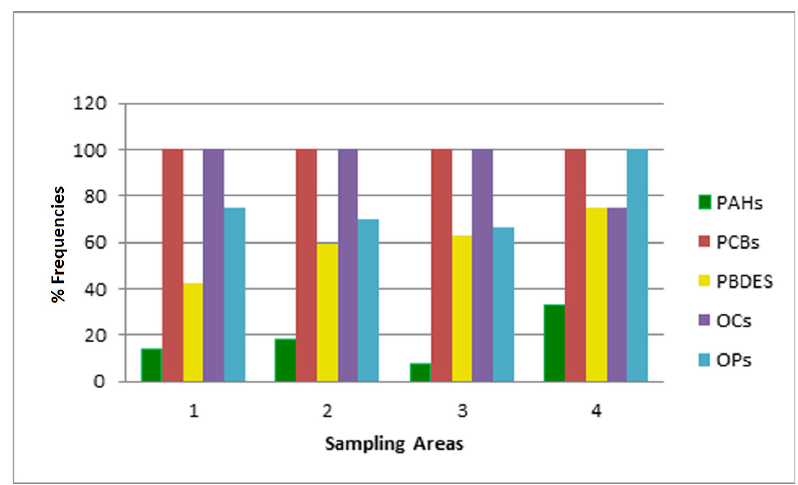
Figure 2. Detection frequencies in the different sampling areas: (1) Intensive orchards; (2) arable lands; (3) areas close to the city without agriculture activities (anthropic sources and traffic); and (4) intensive orchards and arable